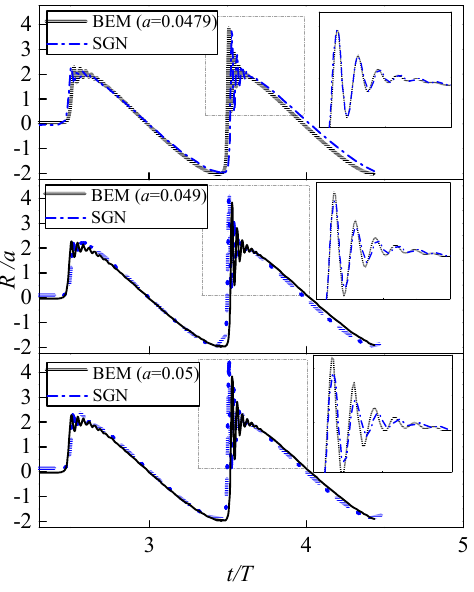
Figure 6. History of wave run-up along the vertical seawall for double-crest wave train cases.